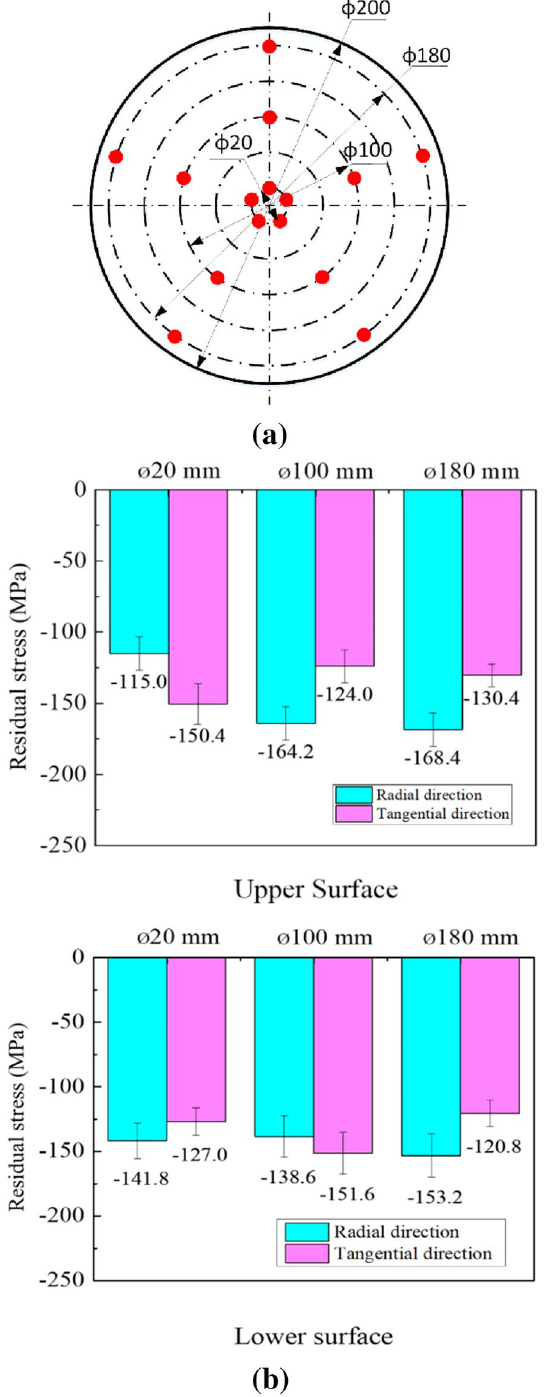
Figure 9 is a deformation diagram of the